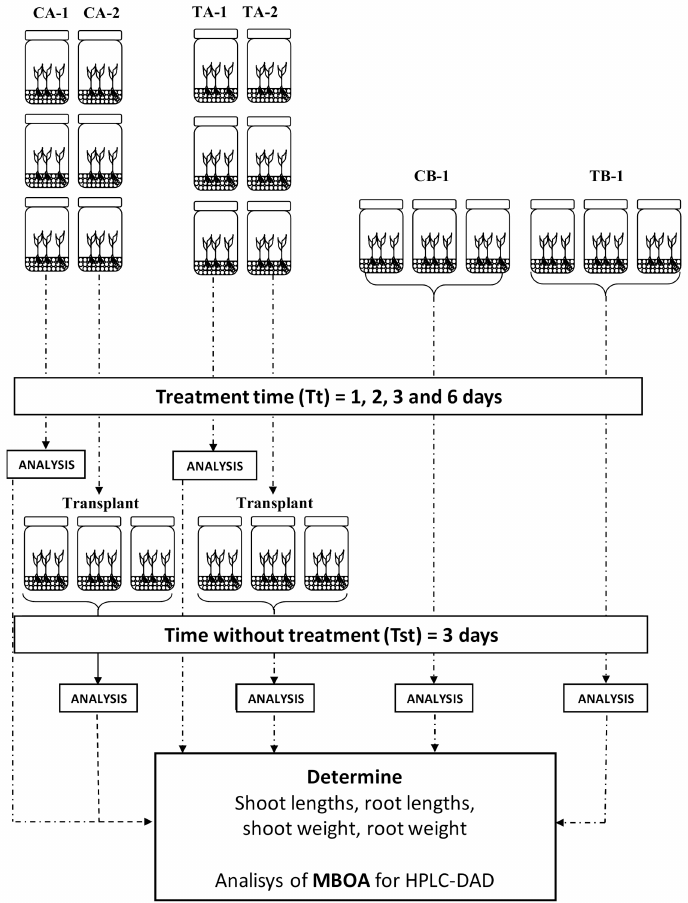
Figure 5. Experimental design for the analysis of the endogenous elimination capacity of the absorbed allelochemical. C = Controls, T = Treatment.